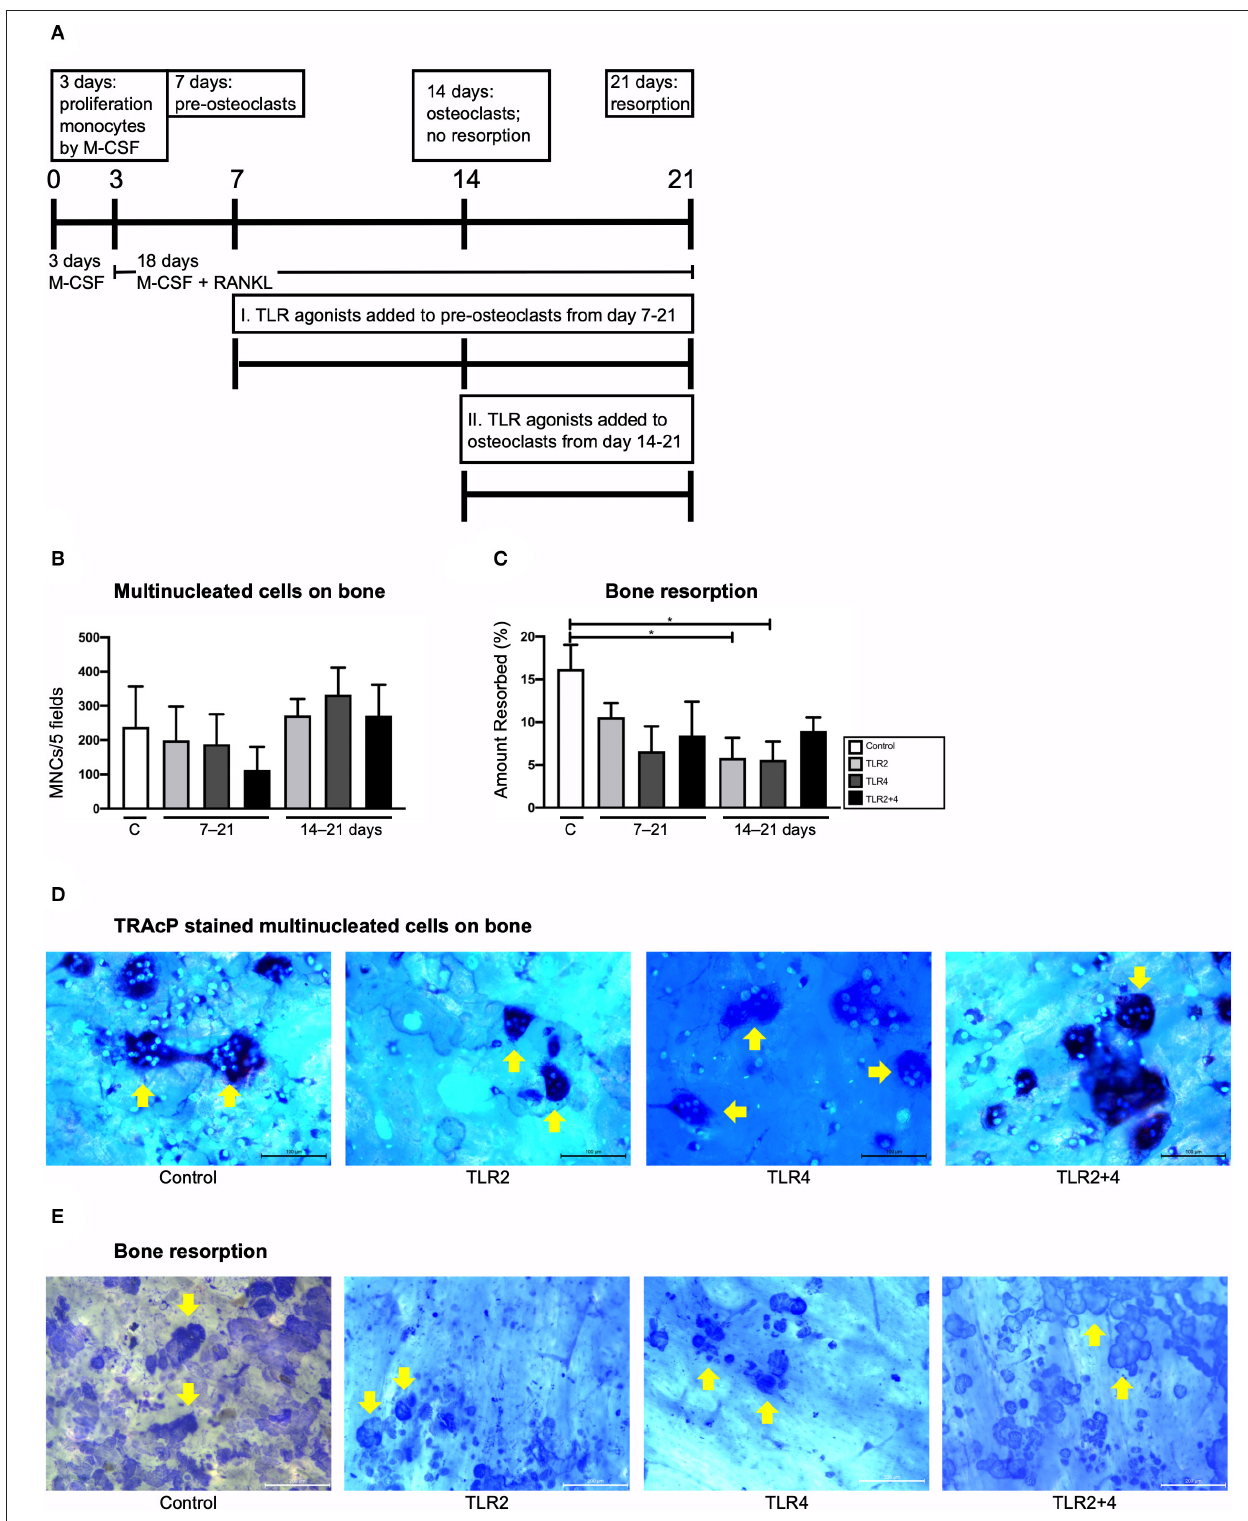
FIGURE 4 | Effect of TLR agonists on the formation of multinucleated cells and on bone resorption in CD14 + monocyte cultures stimulated with M-CSF and RANKL. (A) Flow chart of the conducted experiment. Day 0–3: monocytes were cultured with M-CSF. Day 3–7: M-CSF + RANKL were added to the monocyte cultures.